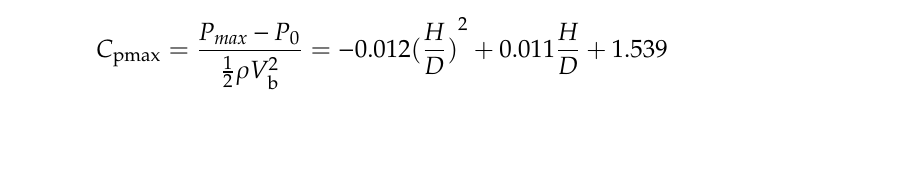
Figure 14. Pressure contour of the plane ( oxy plane) of jet at various impinging height:( a ) H / D = 1; ( b ) H / D = 2; ( c ) H / D = 3; ( d ) H / D = 4; ( e ) H / D = 6; ( f ) H / D = 8.